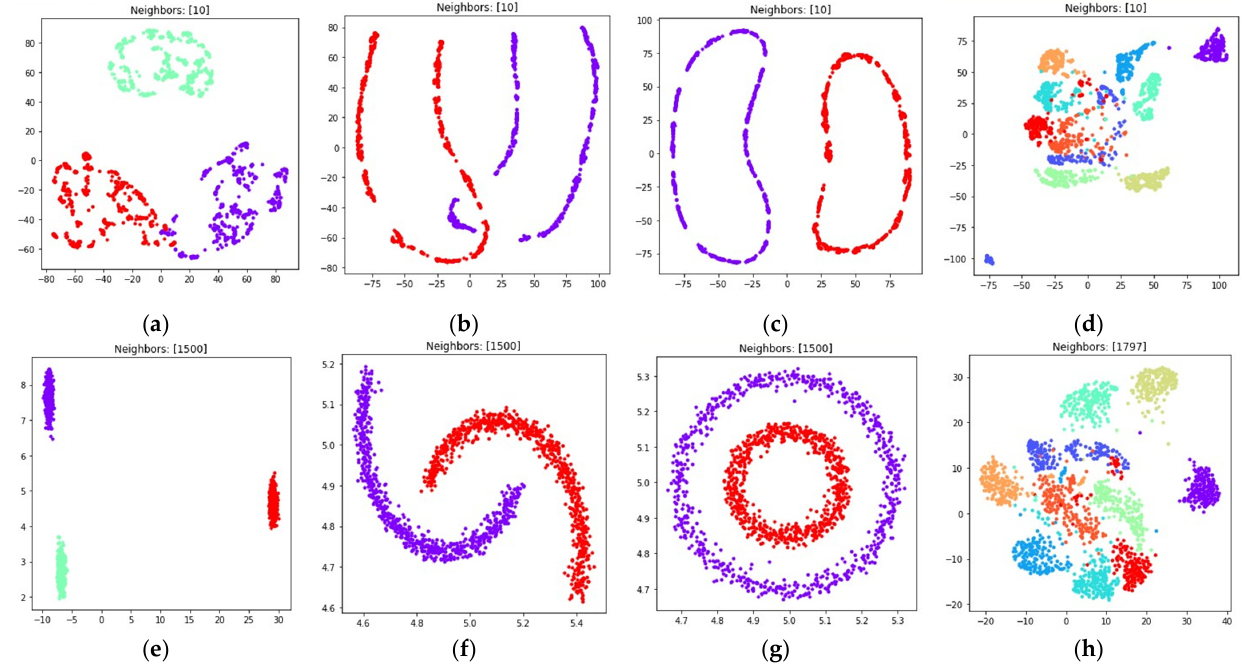
Figure 9. Locations of objects in R 2 with dimensionality reduction performed by applying the UMAP algorithm, with low dimensional embedding optimized by the Adam algorithm, fuzzy cross entropy loss, and the gradient (33) with d min set to 0.1 for: ( a ) blobs, k = 10; ( b ) moons, k = 10; ( c ) circles, k = 10; ( d ) handwritten digits, k = 10; ( e ) moons, k = ( n − 1 ) ; ( f ) blobs, k = ( n − 1 ) ; ( g ) circles, k = ( n − 1 ) ; ( h ) handwritten digits, k = ( n − 1 )